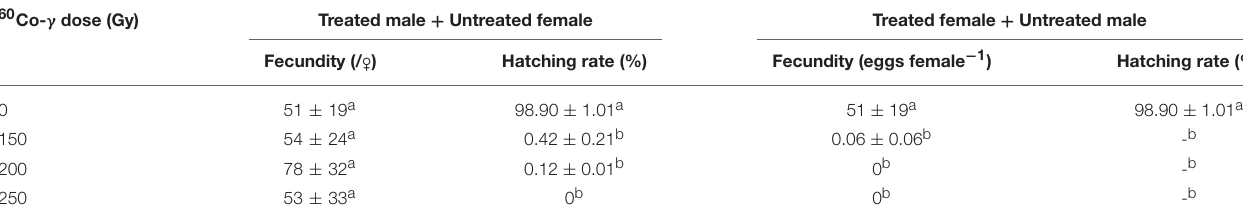
TABLE 3 | Response of adult fecundity and egg hatch rates to different doses of irradiation applied to pupae. 60 Co- γ dose (Gy)